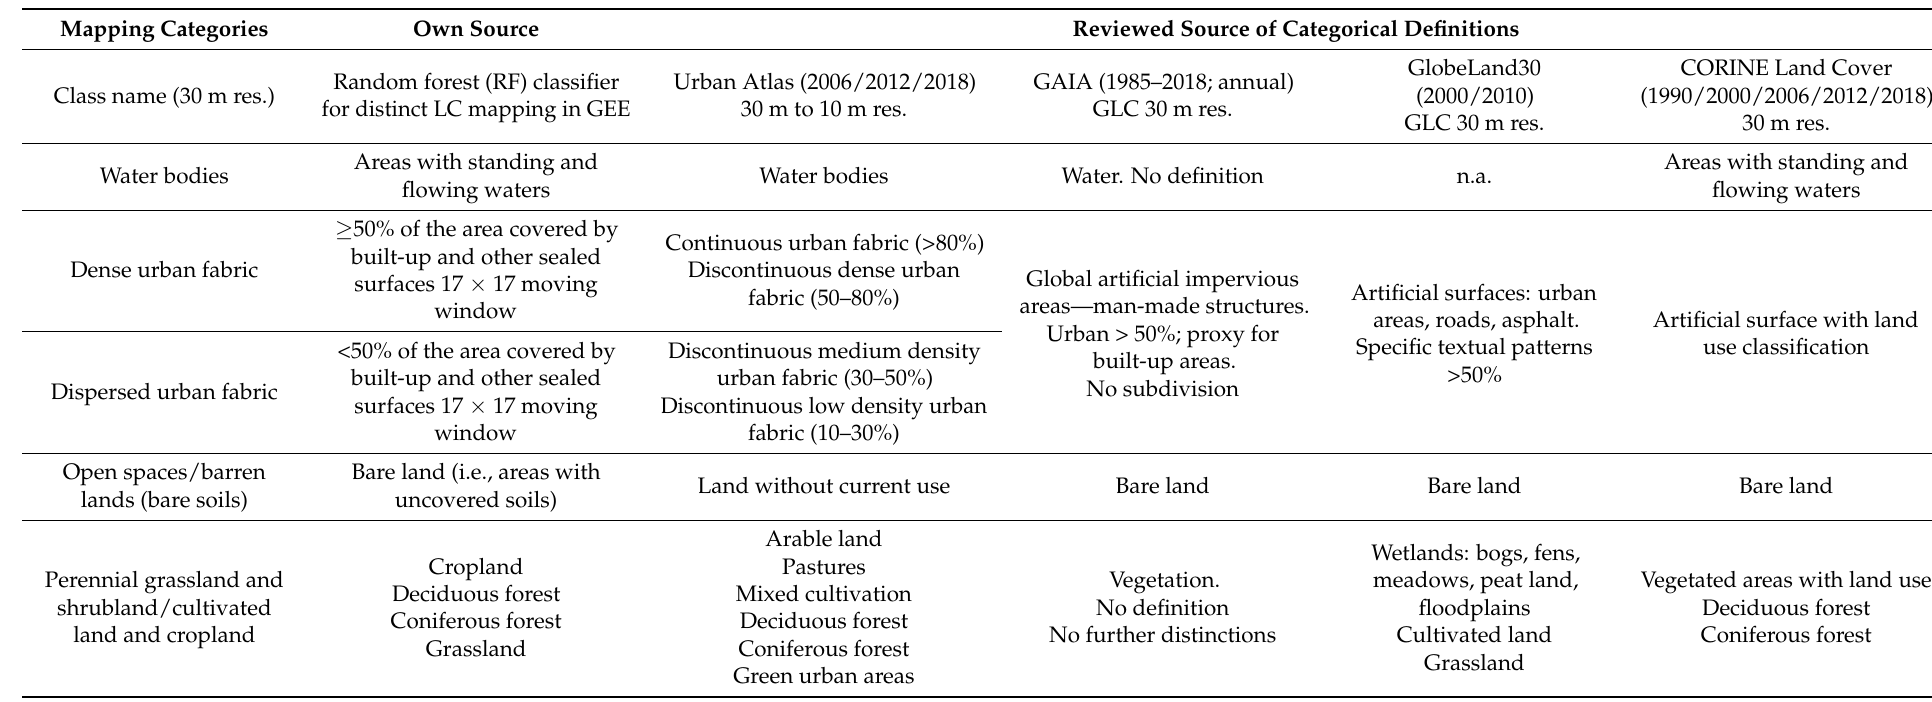
Table 1. Distinction of mapping categories between our own source for the sophisticated LC mapping model and selected global and European data sources. Mapping